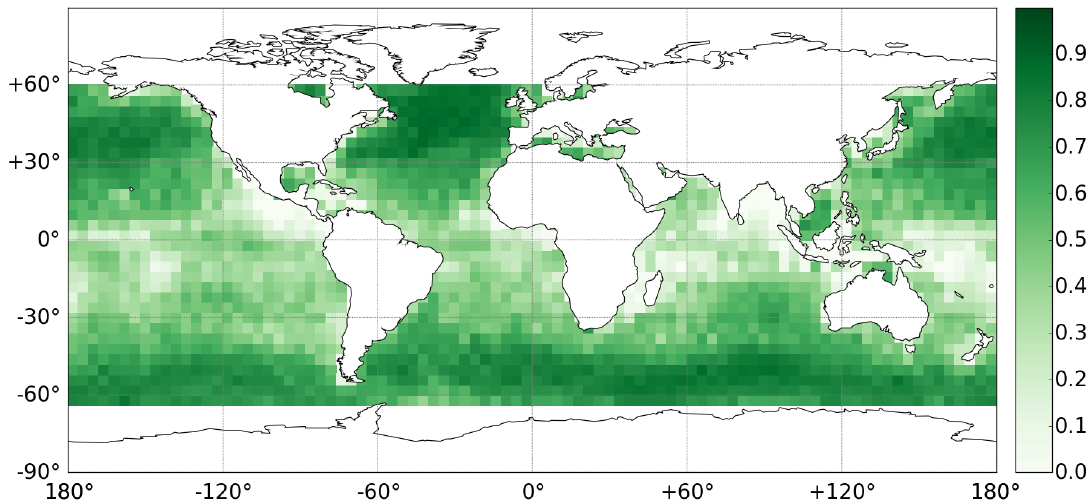
Figure 4. Global correlation between T z G 03 and T z WW 3. Data were binned in lat-lon squares of 4 ◦ by 4 ◦ with swell ratio (SR) deactivated. Largest correlations are found at high latitudes, predominantly in swell ocean